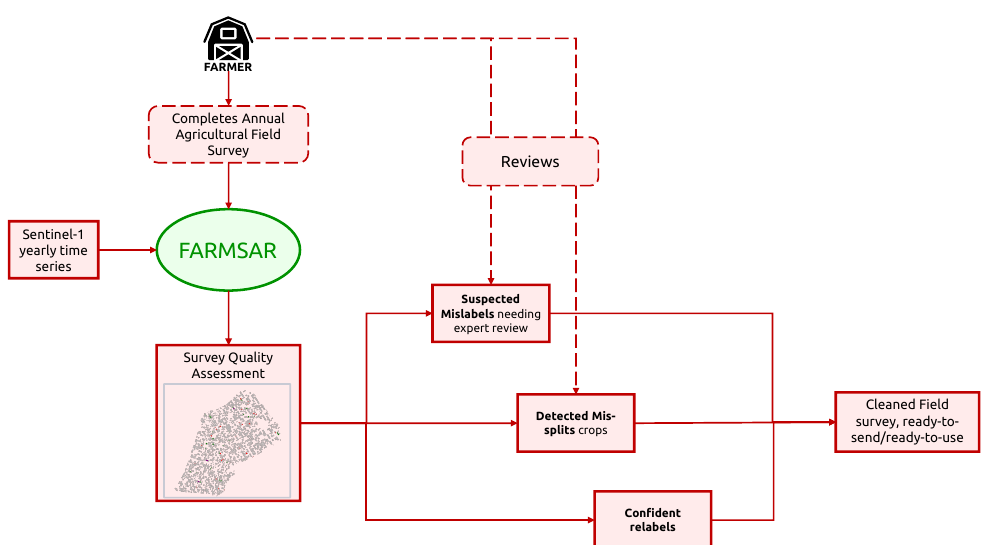
Figure 20. Suggested pipeline of usage of our methodology to support farmer’s field survey